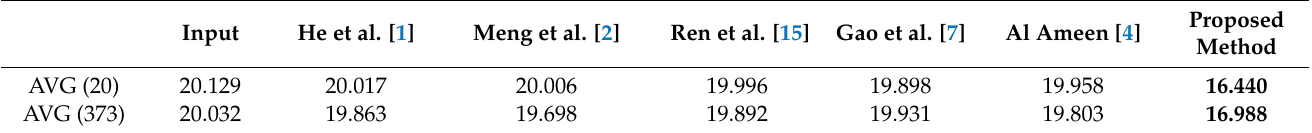
Table 9. The comparison of the NIQE [33] average scores on sample images (Figures 6 and 7) and the DWAN dataset [32] (The lowest scores are indicated in bold ).